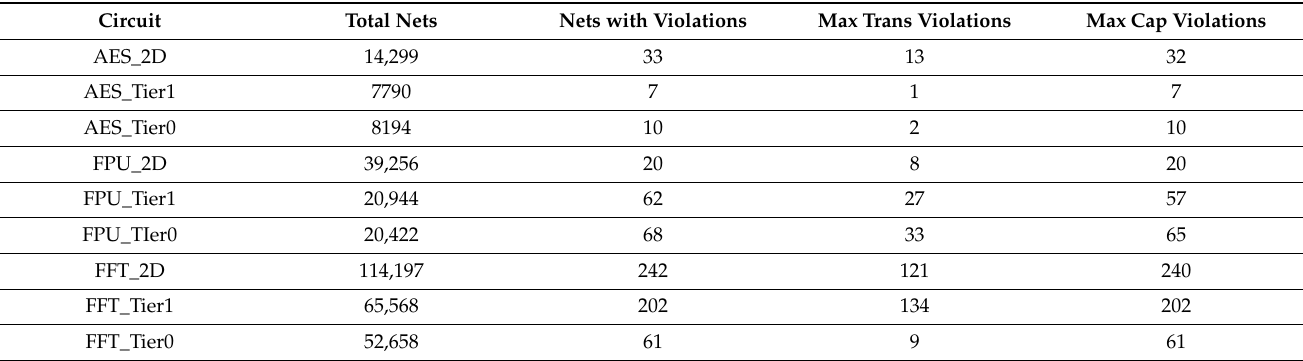
Table 4. Timing violation information for the 2D and two-tier 3D benchmark